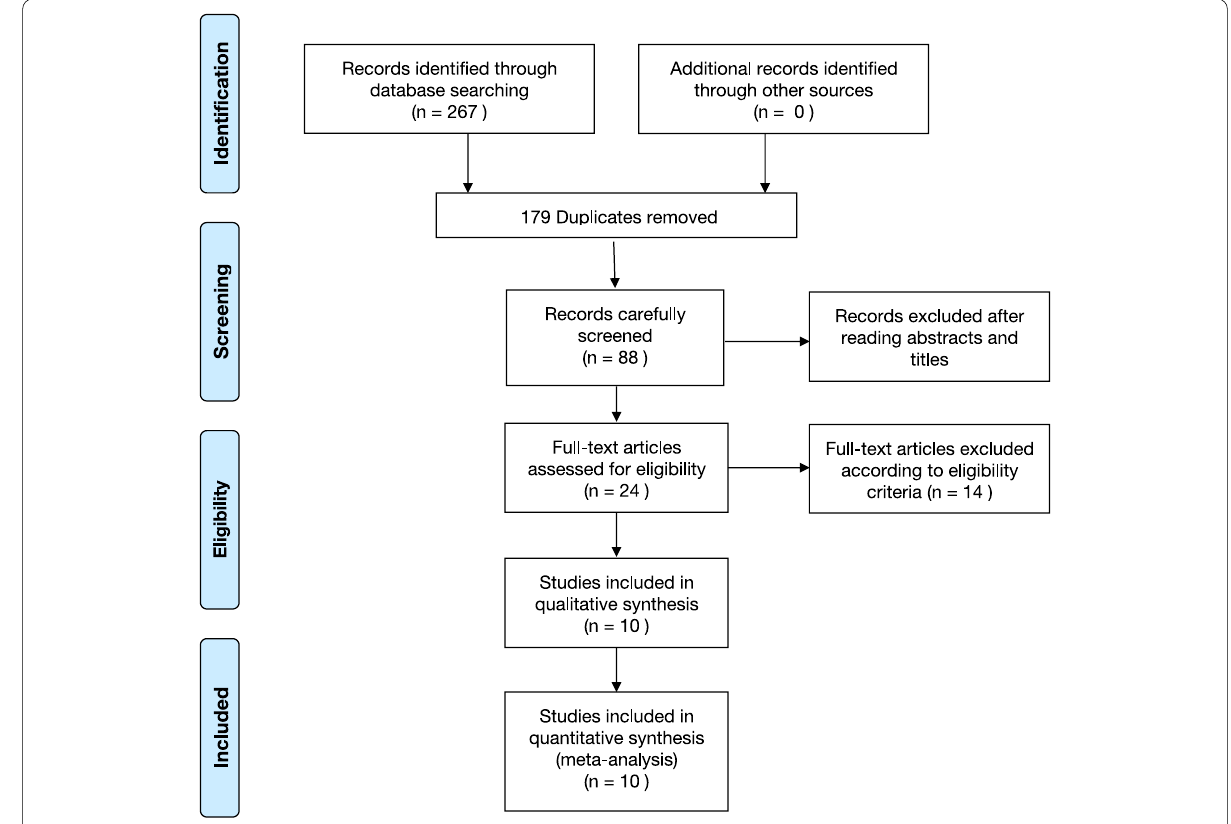
Fig. 1 PRISMA flow chart describing the selection of articles at each stage of the